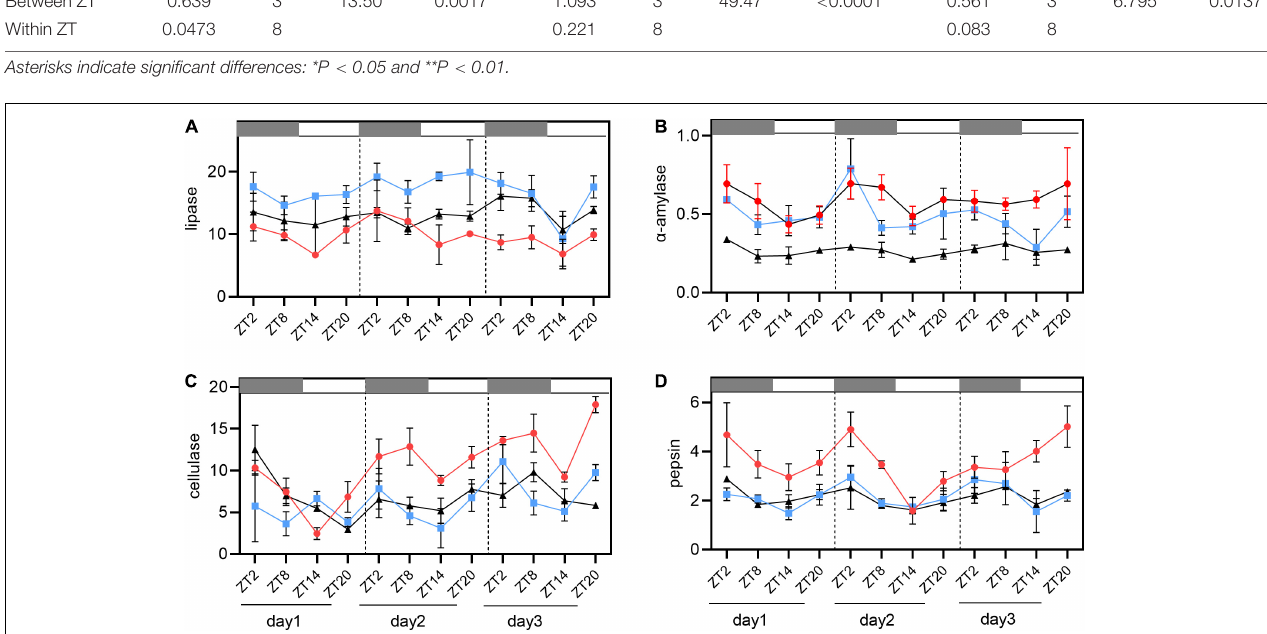
FIGURE 2 | Analysis of four digestive enzyme activities in 12 h light/12 h dark (L/D) cycles during 3 days. (A) Lipase activity diagram. (B) α -amylase activity diagram. (C) Cellulase activity diagram. (D) Pepsin activity diagram. Values are represented as means ± SD ( n = 4). Group A, B, C are three parallel tanks with the same cultivating conditions, and the red circle represents Group A, the blue square represents Group B and black triangle represents Group C. The gray grid represents the dark time point.